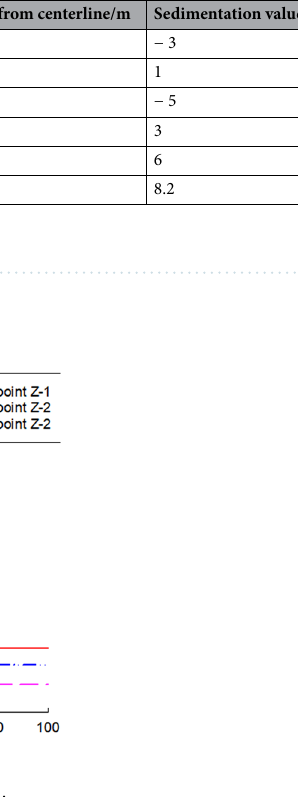
Figure 5. Fitness change diagram of the left measuring